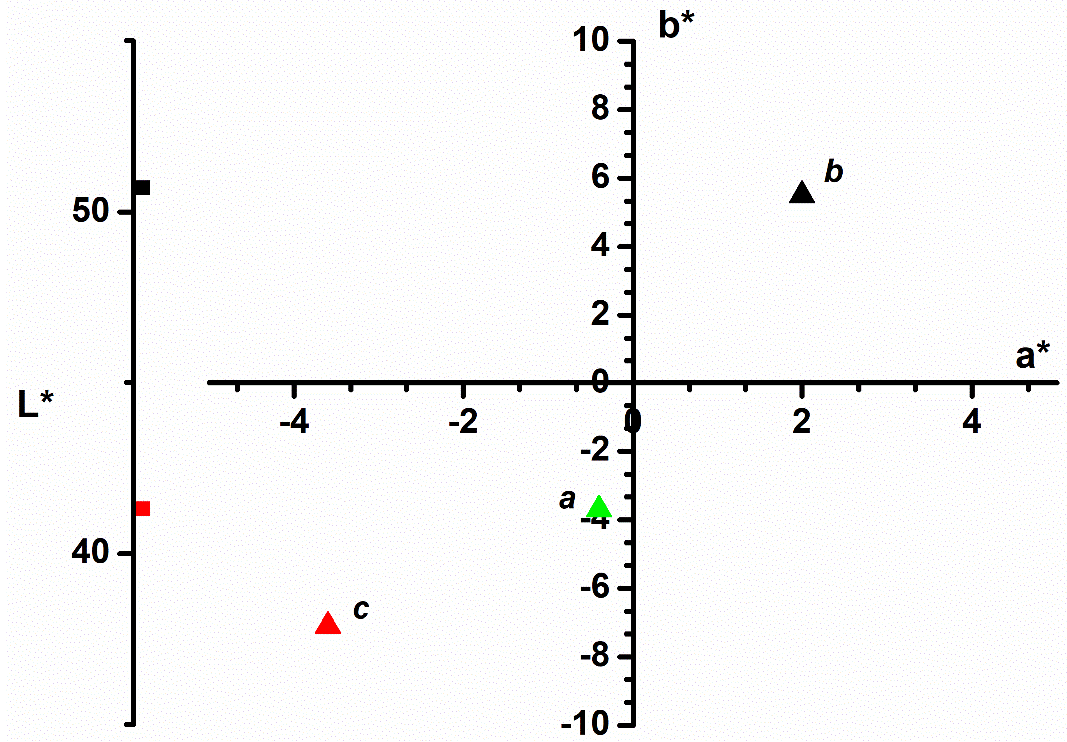
Figure 2. CIEL*a*b* color parameters of the following: a -methylene blue dye; b -raspberry leaves before adsorption process; c -raspberry leaves after adsorption process.